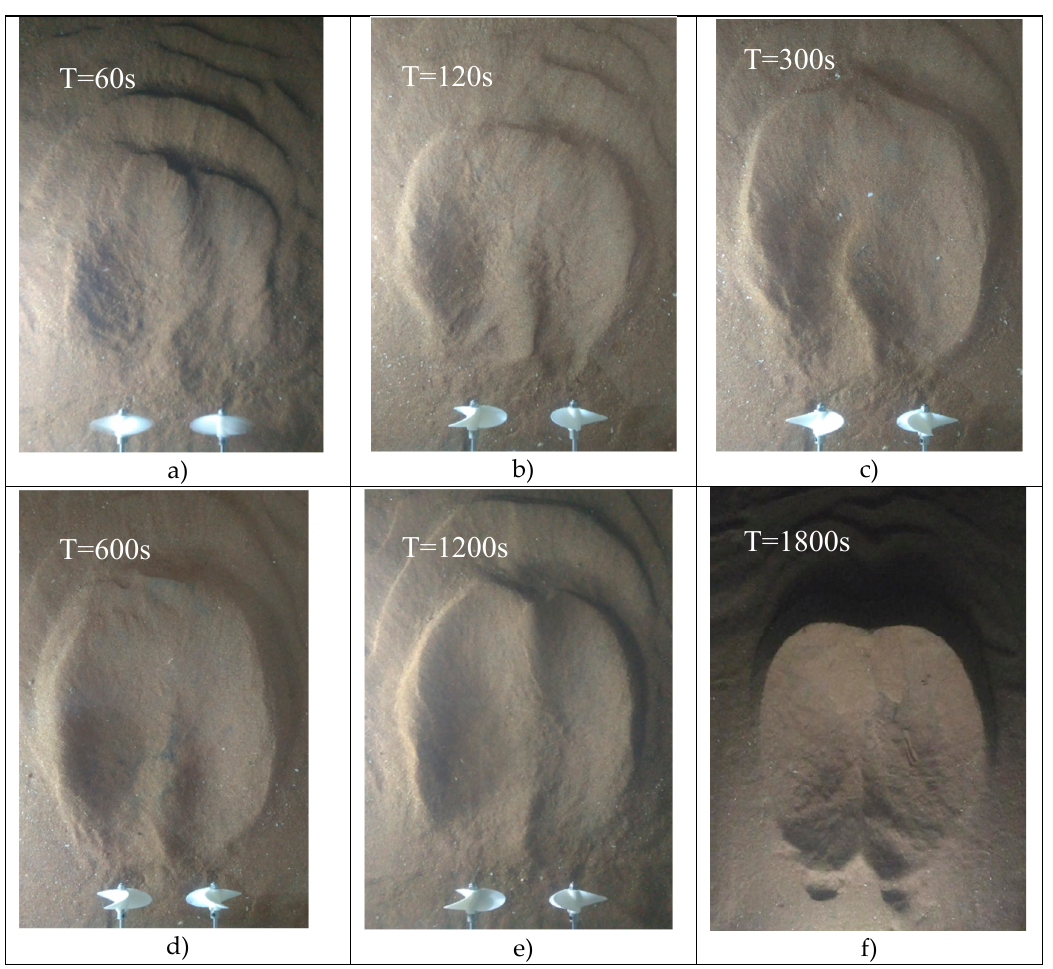
Figure 6. Temporal scour processes for twin-propeller, ( a ) 60 s; ( b ) 120 s; ( c ) 300 s; ( d ) 600 s; ( e ) 1200 s; ( f ) 1800 s.